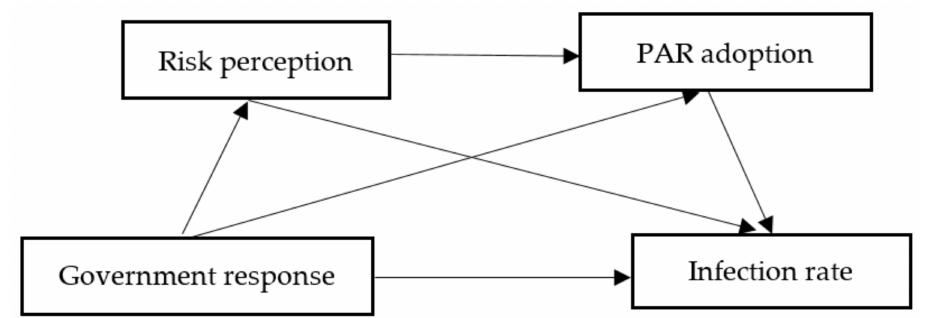
Figure 1. Conceptual